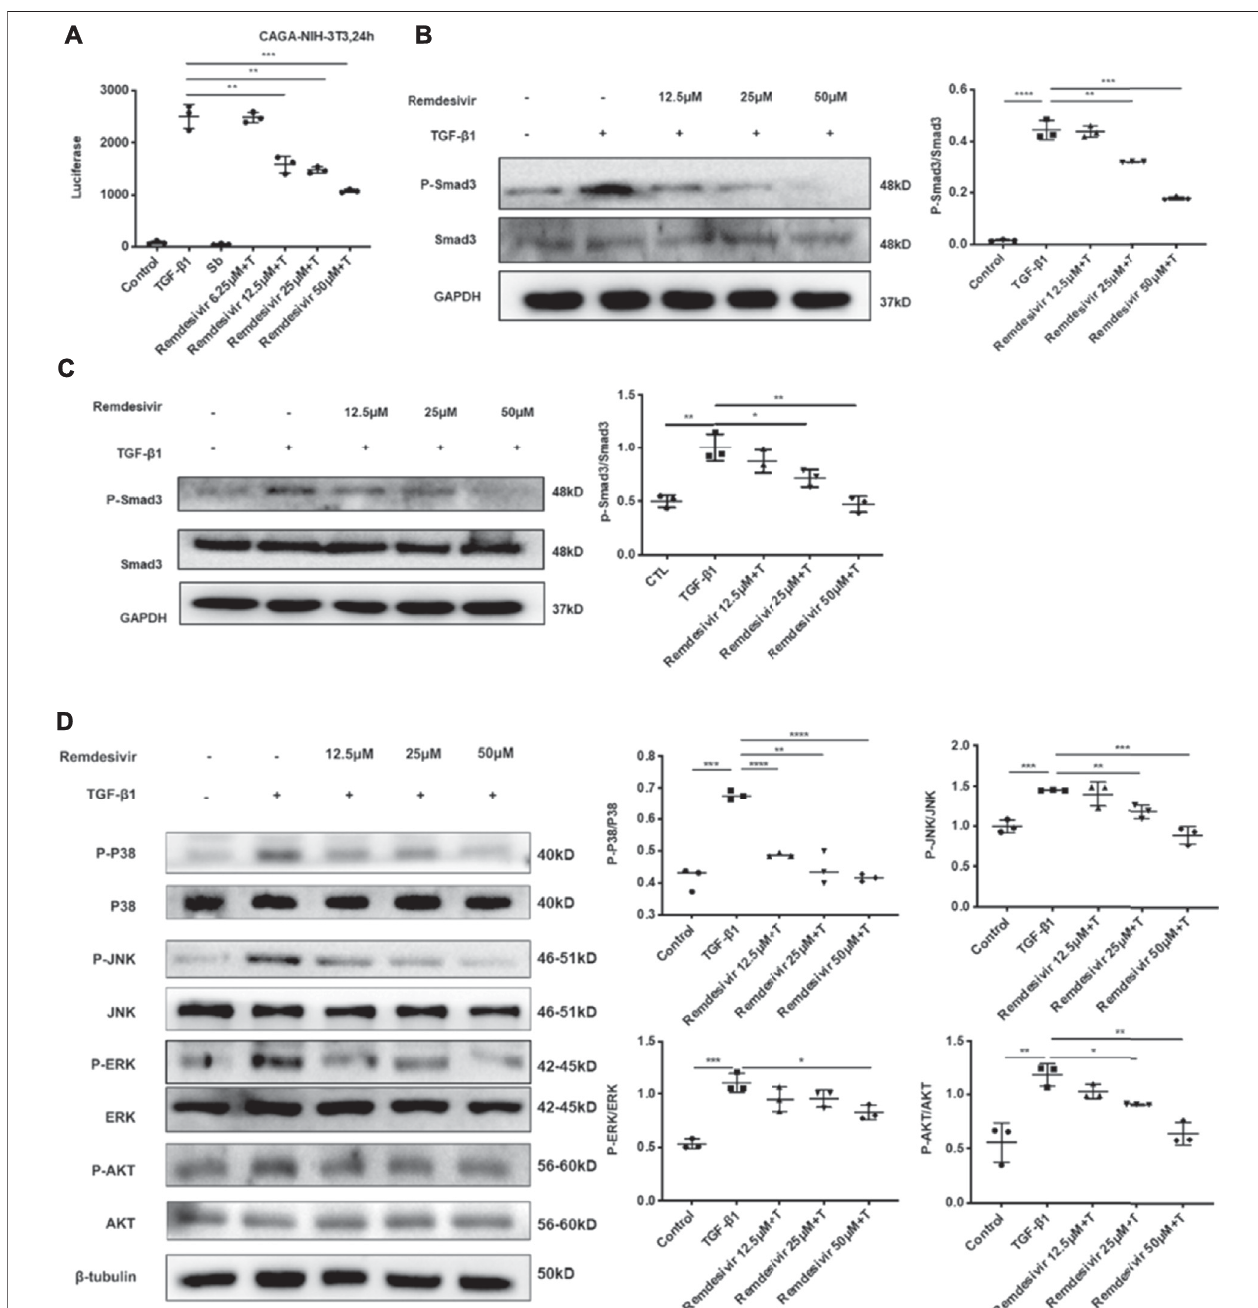
FIGURE 6 | Remdesivir inhibits TGF- β 1-induced activation of Smad and non-Smad signaling pathway in lung fi broblasts (A) Luciferase assays of CAGA-NIH3T3 cells.CellswerepretreatedwithRemdesivir(0 – 50 μ M)for30 minandthenincubatedwithTGF- β 1(5 ng ml − 1 )for24 h,thenanalyzedwithluciferaseassay.SB431542is a TGF- β 1/Smad pathway inhibitor and serves as a positive control (B) NIH-3T3 cells were co-treated with TGF- β 1 (5 ng ml − 1 ) and Remdesivir (12.5, 25, 50 μ M) for 1 h. P-Smad3 and Smad3 were assessed using western blot. GAPDH was used as the internal control (C) PPF cells were co-treated with TGF- β 1 (5 ng ml − 1 ) and Remdesivir (12.5, 25, 50 μ M) for 1 h. P-Smad3 and Smad3 were assessed using western blot. GAPDH was used as the internal control (D) NIH-3T3 cells were co-treated with TGF- β 1 (5 ng ml − 1 ) and Remdesivir (12.5, 25, 50 μ M) for 1 h and the phosphorylation levels of P-38, JNK, ERK and Akt were analyzed by Western blot. β -tubulinwasusedasaloadingcontrolingrayscaleanalysis.Scalebar (cid:1) 60 μ m.Datawaspresentedasthemeans ± SD, n (cid:1) 3.* p < 0.05,** p < 0.01,*** p < 0.001, **** p <